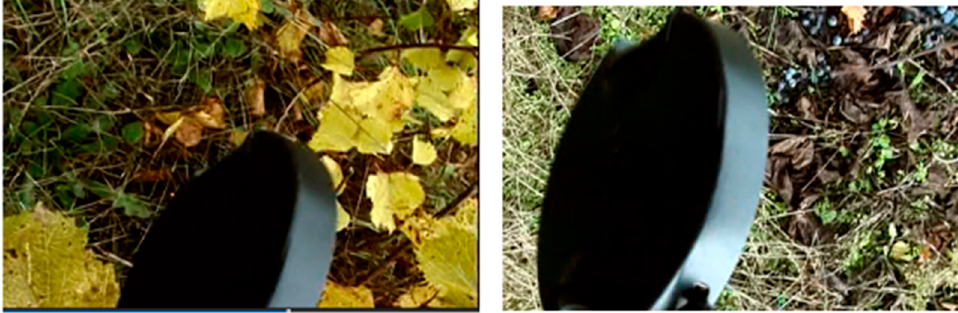
Figure 13. Selected stills from the ‘dancing lens cap sequence’ which, in total, lasts almost 50 s. I have discussed elsewhere the ideological significance of relying on vision as the primary means of encountering the world in travel narratives, and how the displacement of ocularcentrism can be interpreted as a means of closing the gap between self and other, of relinquishing the safe position of spectator in favour of the fully imbricated—and more vulnerable—, multisensory experience of di ff erence (Topping 2019a, pp. 283–85; 2019b, pp. 194–206). Su ffi ce it to reiterate here,